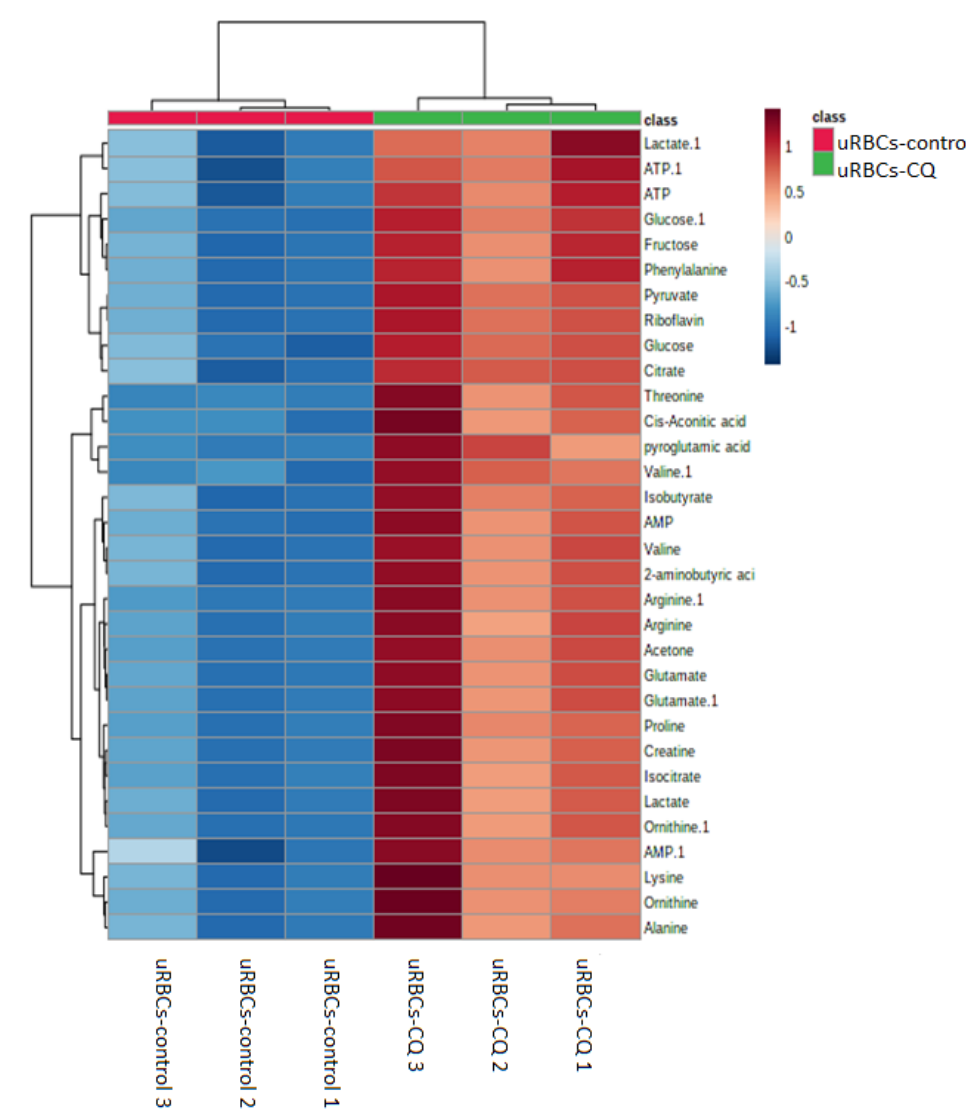
Figure 11. Heat map of the identified biomarkers of uRBCs-control and uRBCs-CQ obtained from HCA by using Ward’s minimum variance method and Euclidean distance. The concentration of each metabolite is colored based on a normalized scale from minimum −1 (dark blue) to maximum 1 (dark brown). uRBCs, uninfected red blood cells; CQ, chloroquine.